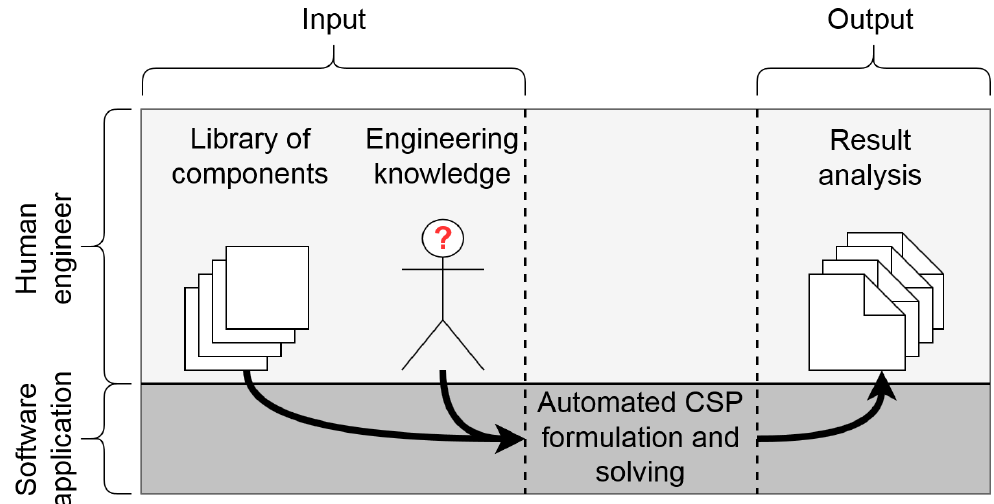
Figure 2. Visualization of methodology: generation of topologies with the use of formalized component properties and engineering